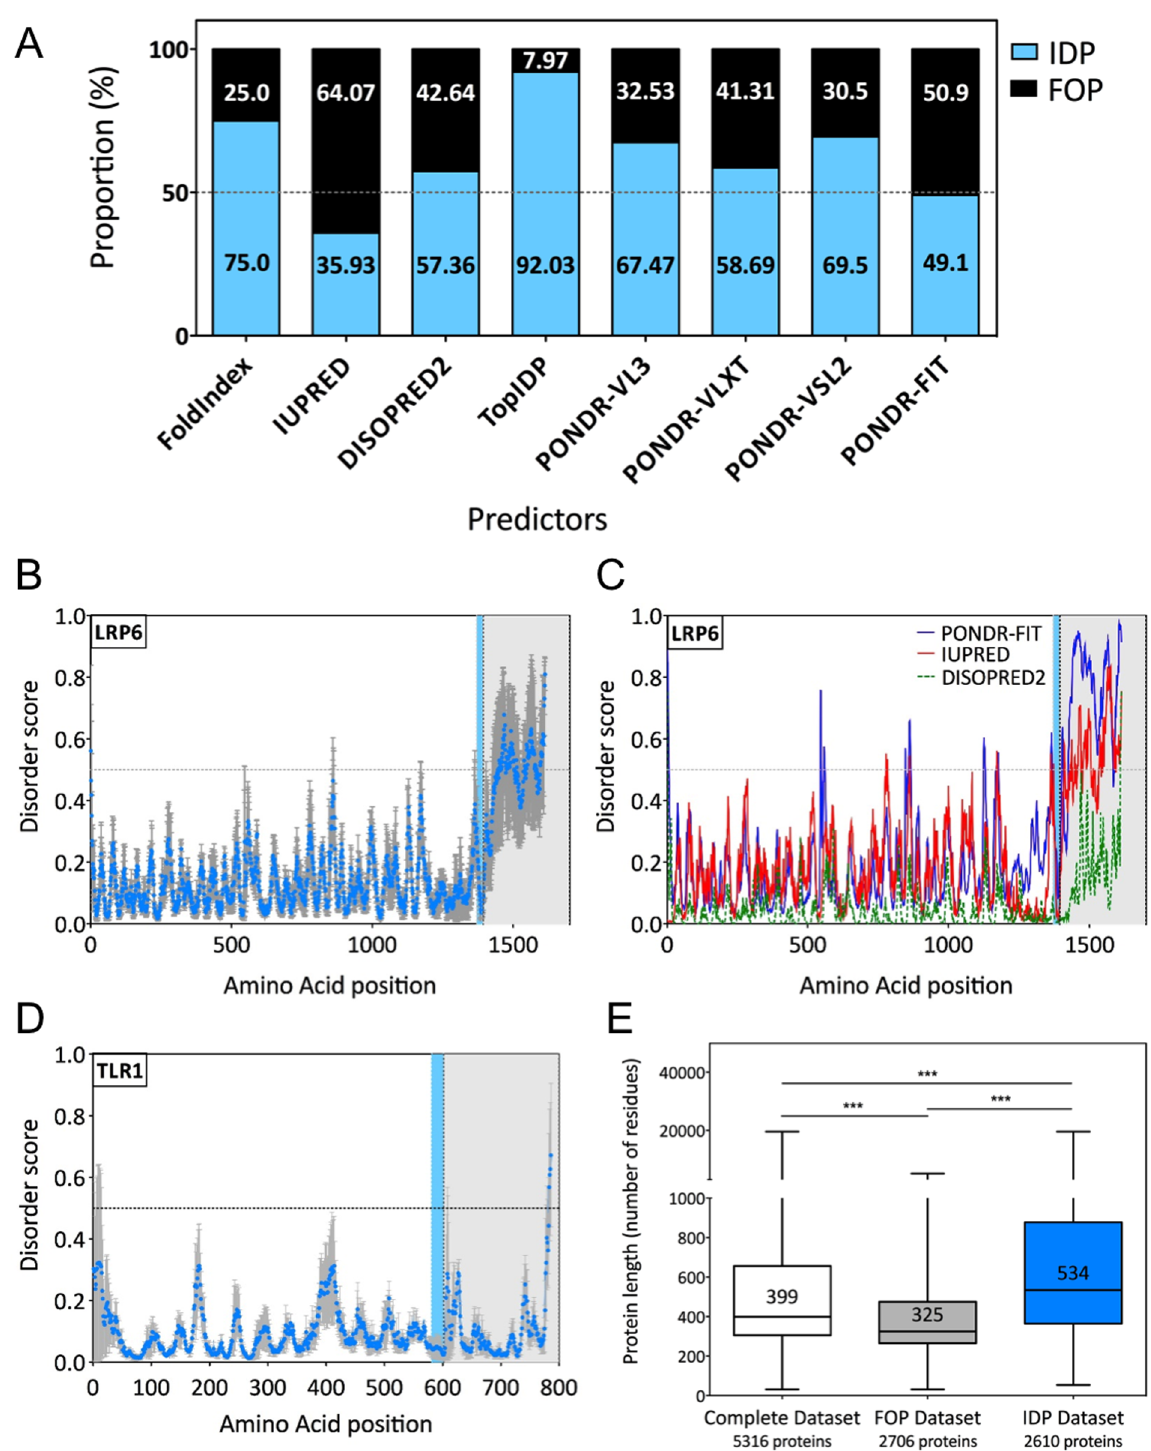
Fig 1. Computational prediction of intrinsically disordered domains (A) Proportion of proteins having at least 30 consecutive amino acids predicted as disordered according to 8 different predictors. (B and C) Average disorder prediction of the protein LRP6 (UniProtID: O75581) using three different tools (IUPRED, DISOPRED2 and PONDR-FIT). For (C) The blue line represent PONDR-FIT prediction, the red line IUPRED prediction and the green discontinuous line DISOPRED2 prediction. (D) Average disorder prediction of the ordered protein TLR1 (UniProtID: Q15399) using three different prediction tools (IUPRED, DISOPRED2